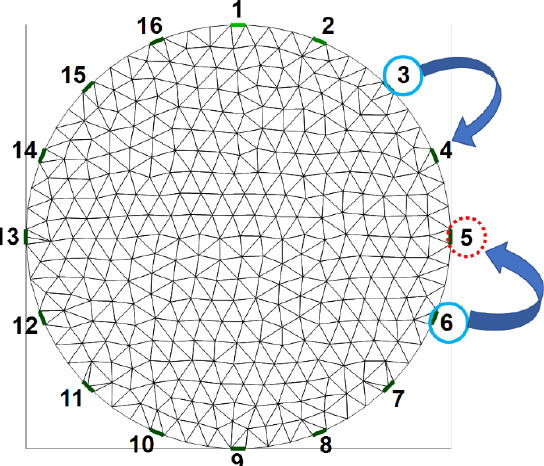
Figure 4. Illustration of voltage-replace method.